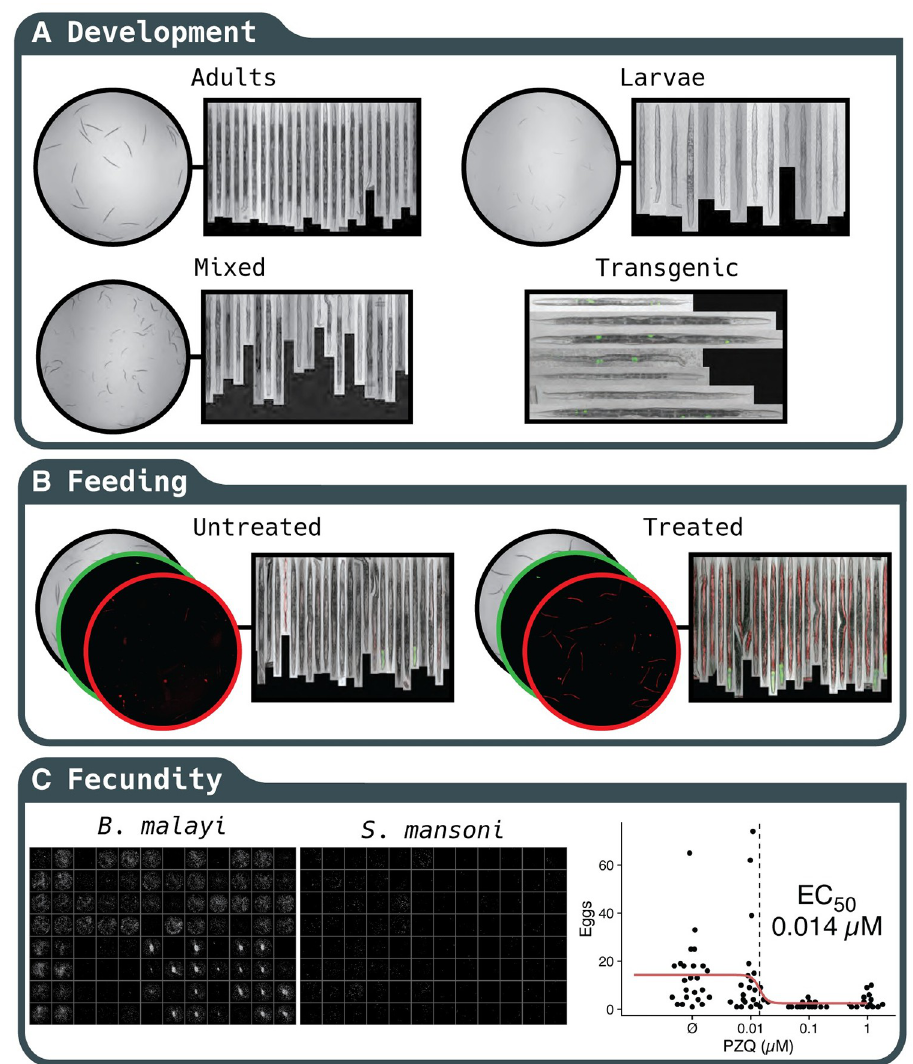
Fig 4. Examples of phenotypes that can be analyzed with wrmXpress. (A) An analytical module is available for measuring C . elegans development, which performs well with mixed populations. Classification of transgenic worms ( unc-122p :: GFP ) is also implemented. (B) Quantification of C . elegans feeding using fluorescent dyes, which can be measured in the worm intestine. (C) Quantification of the in vitro fecundity of Brugia spp. and S . mansoni adults. machine learning and statistical models and selected a gradient boosted tree due to its perfor- mance and speed of classification on experimental data (Fig 5A). The trained model used the minimum y (length) of the bounding box, the minimum and standard deviation of the inten- sity of the edge pixels, and the solidity (the ratio of the contour area to its convex hull area), among others, as the most important variables (Fig 5B). The model achieved an area under the receiver-operator characteristic curve (AUC ROC) of 0.827 and a sensitivity of 0.609 (S1 File). When fit to annotated holdout data and retaining only those predicted to be single worms, the model removed 93% of the debris, 89% of multiple worms, 93% of partial worms, and only 18% of single worms, substantially enriching for objects of interest. In our hands, using a sin- gle, less stringent worm model in CellProfiler followed by post-processing filtration decreased